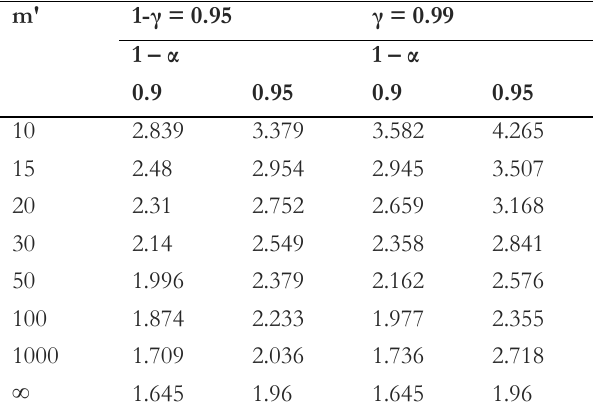
Table 2. Tolerance factor k for a number of collected data (m’), a proportion of the data (1 - α), and a confidence level 1-